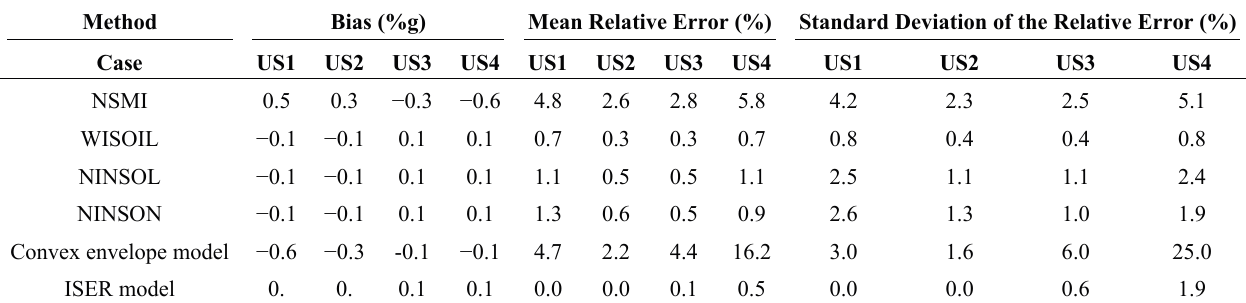
Table 8. Synthesis of the relative error (mean, standard deviation) (Equation (7)) and bias values (Equation (8)) computed on the estimated SMC for US0 case and the corresponding SMC for other simulation